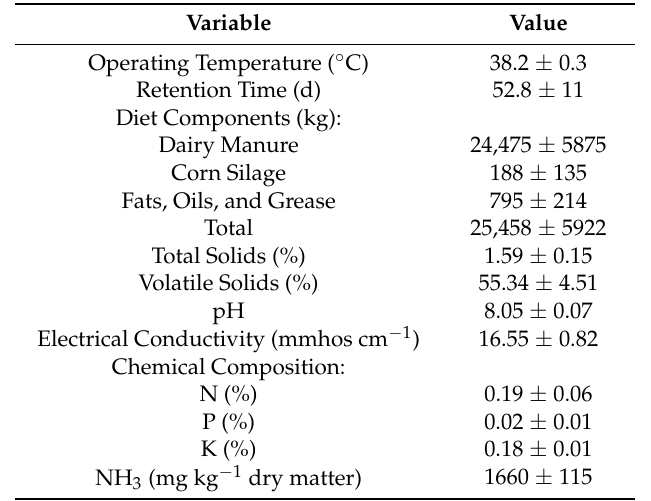
Table 1. Operating conditions of the 250 kW commercial-scale anaerobic digester that inoculum was retrieved from for each experimental run, as well as characteristics of the digestate used for biological methane potential assays. Values represent means ± standard